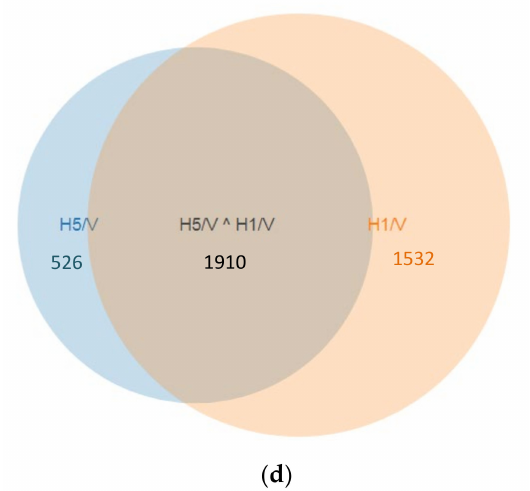
Figure 1. Microarray analysis of 8-OHD-treated K562 cells. ( a ) Chemical structure of 8-OHD. ( b ) Principal component analysis (PCA) of microarray data obtained from analyzing duplicate samples of vehicle (V) and 8-OHD treated at 50 µ M (H5) and 100 µ M (H1). ( c ) Heatmap of enriched gene ontology (GO) terms associated with 50 and 100 µ M 8-OHD differentially expressed genes (DEGs). GO processes listed in the upper half are terms of upregulated DEGs. The lower processes are GO terms of downregulated DEGs. Only some of the representative GO terms are shown. ( d ) Venn diagrams demonstrating the numbers of common downregulated DEG between those treated with 50 µ M 8-OHD (H5) and 100 µ M 8-OHD (H1) compared to that of vehicle (V), based on the threshold of multiples of change of >1.5 or < − 1.5, and p < 0.05. The 'ˆ' symbol represents the intersection of two